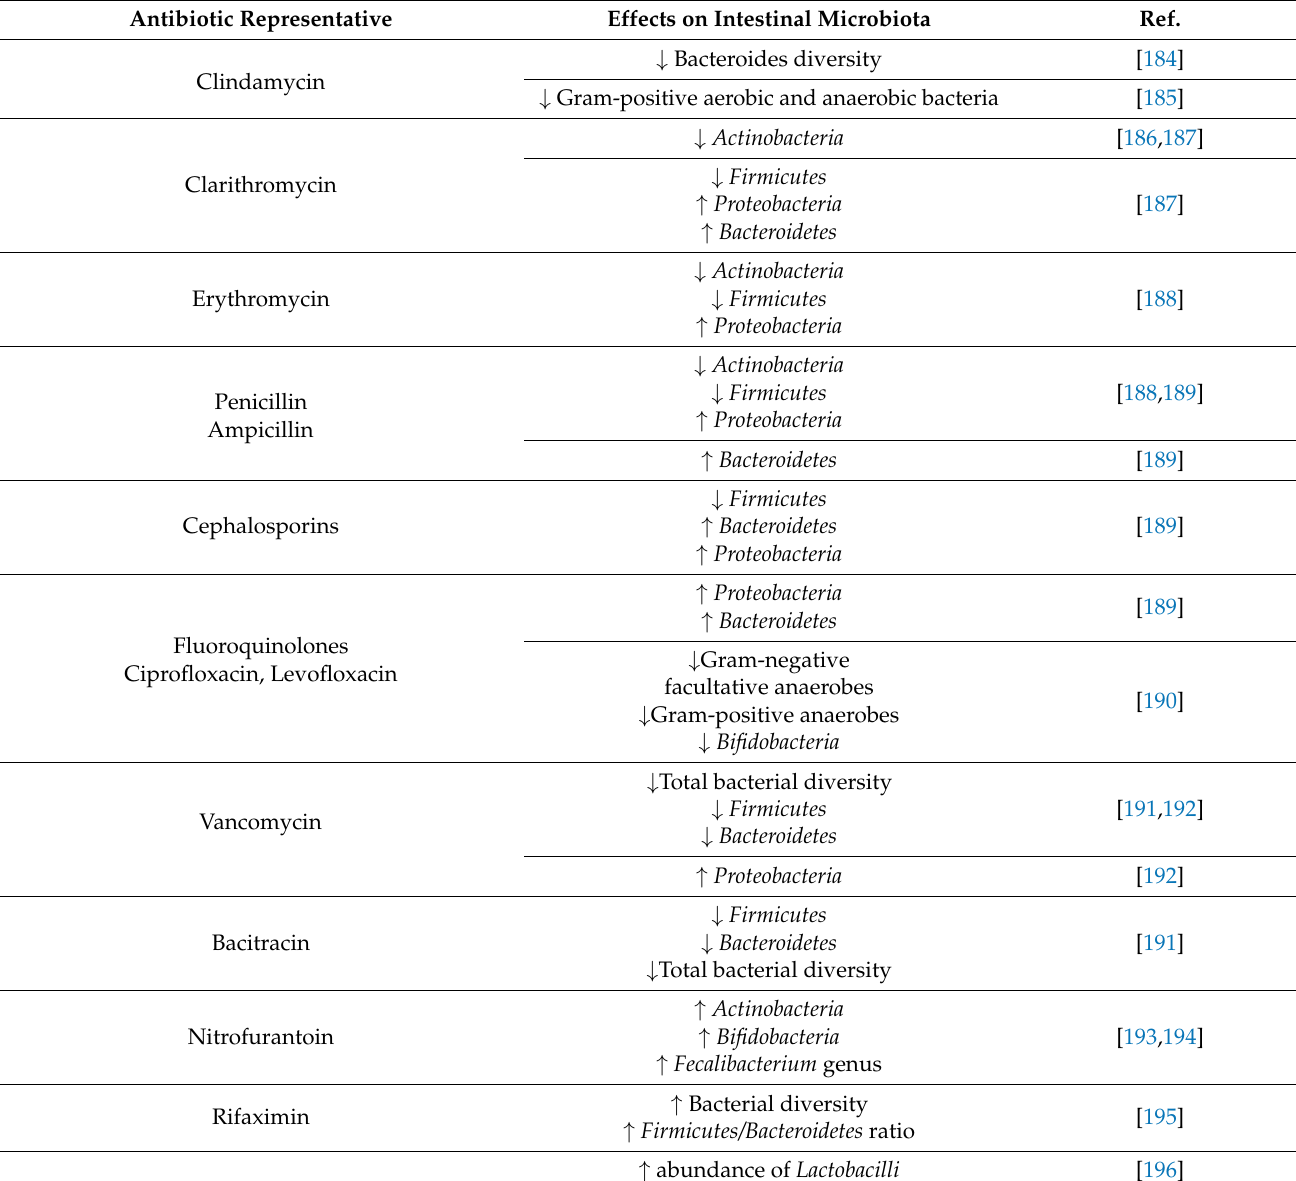
Table 3. The effects of different antibiotics on gut